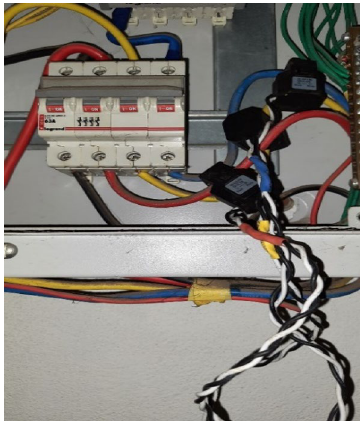
Fig. 4 CTs clamped to DB box. The CTs are clamped to the incoming supply wires represented with red, yellow and blue colours. The other end of CT wires is connected to Garud